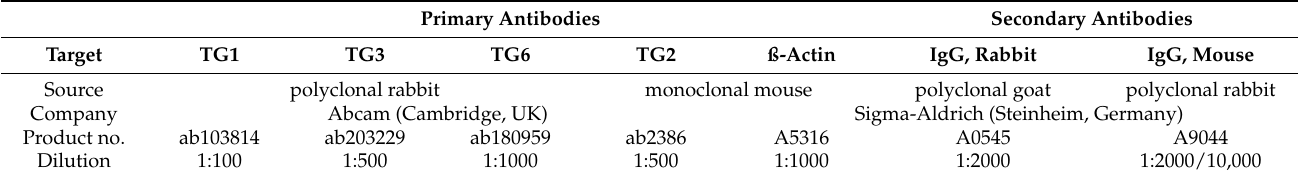
Table 2. Antibodies and their specifications used for Western blot